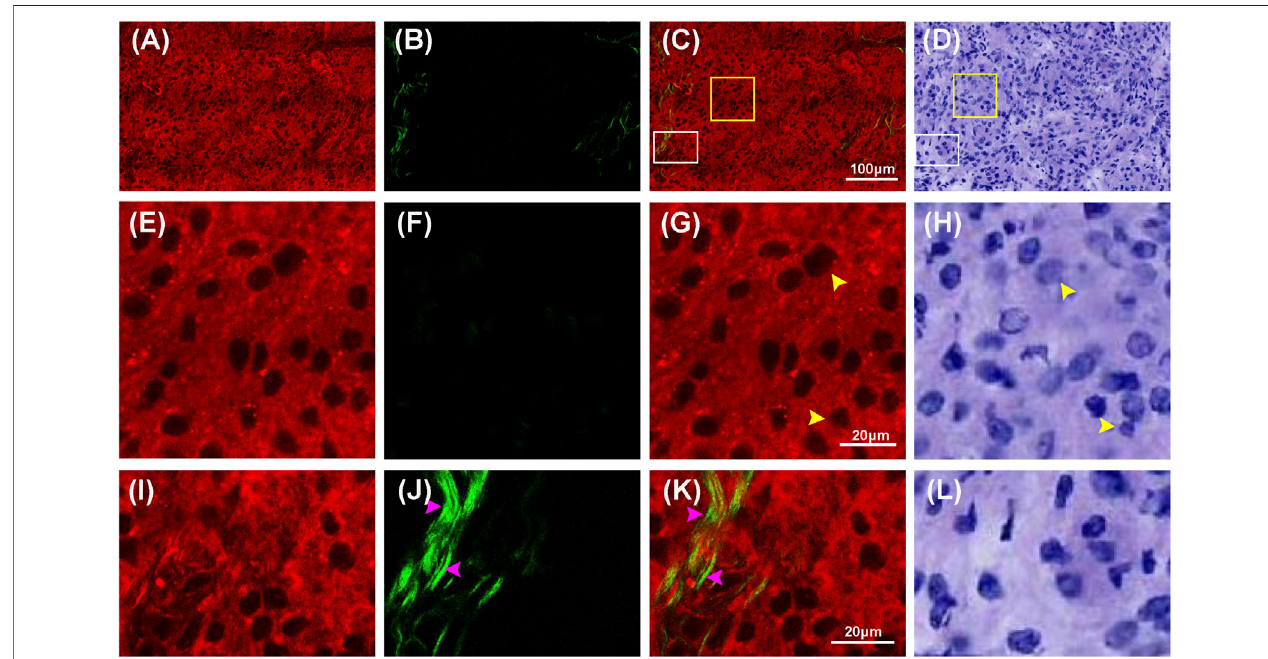
FIGURE 4 | Representative MPM images and the corresponding images of H&E stained low-grade glioma. (A – D) TPEF, SHG, TPEF/SHG overlaid images, and corresponding image of H&E stained low-grade glioma. (E – H) The magni fi ed TPEF, SHG, TPEF/SHG overlaid images, and corresponding H&E image of the selected area (yellow square box) in Figure 4C . (I – L) The magni fi ed TPEF, SHG, TPEF/SHG overlaid images, and corresponding H&E image of the selected area (white square box) in Figure 4C . Yellow arrowheads: cells in low-grade glioma; pink arrowhead: collagen in low-grade